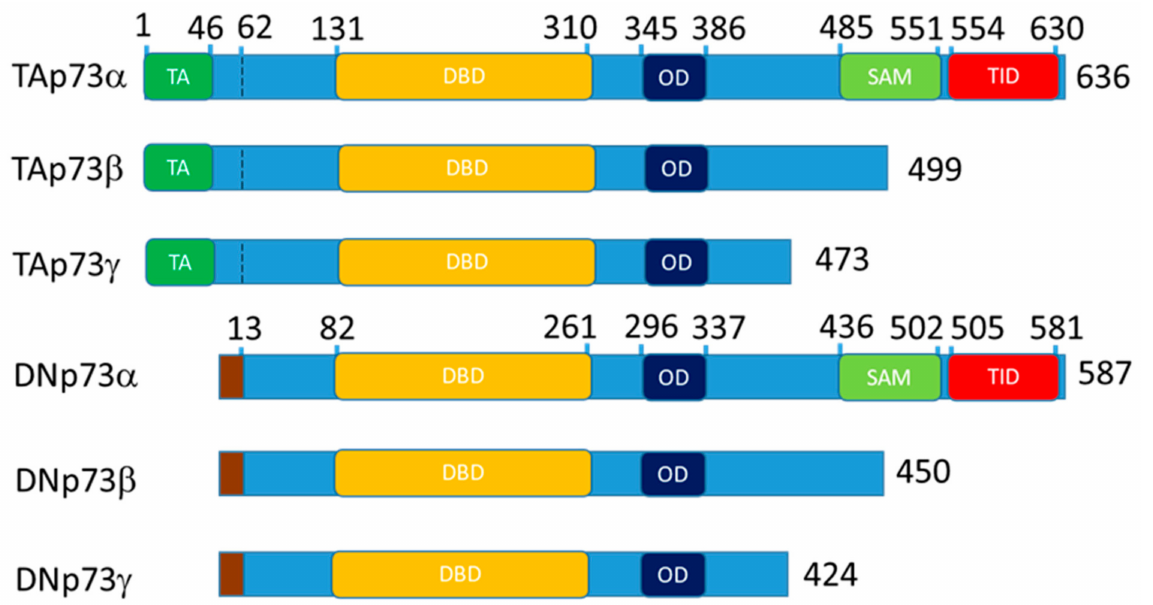
Figure 1. Schematic representation of the p73 domain structure for the main isoform expressed in the epithelial tissue. The p63 follows the same nomenclature. Altogether, 13 isoform of p63 and 13 isoforms of p73 exist. DN- isoforms begin with the stretch of 13 amino acids that replace TA domain at 62 bp. The TAp73a coordinates are for the O15350 protein and DNp73a coordinates are for the BAB87244.1 protein. TA—transactivation domain, DBD—DNA binding